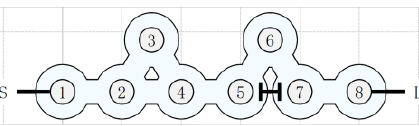
Figure 3. Cascaded triple topology.